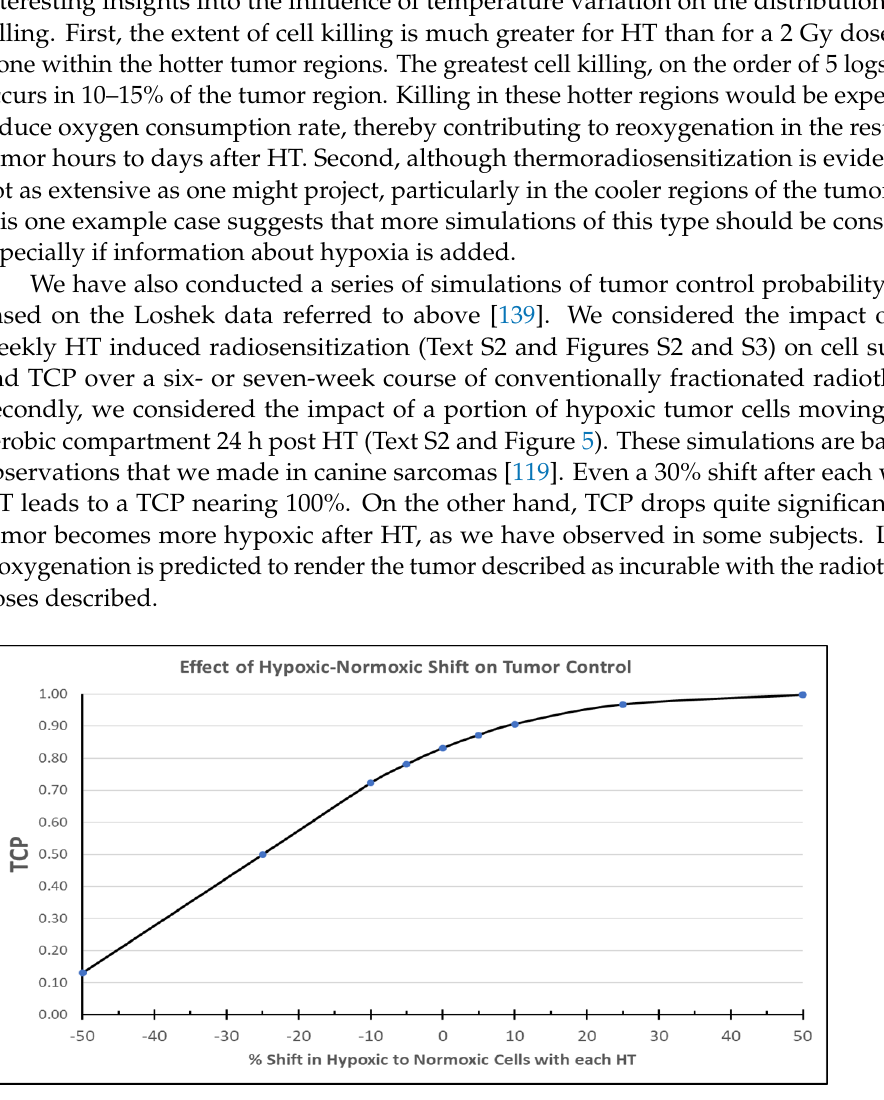
Figure 5. Predicted tumor control probability [TCP] for conventionally fractionated radiotherapy + HT, where HT is administered once weekly. The impact of HT induced reoxygenation at 24 h post HT is depicted, as the proportion of hypoxic cells that reoxygenate vs. proportion of aerobic cells that become more hypoxic after each HT. TCP reaches nearly 100% if even 30% of hypoxic tumor cells reoxygenate 24 h after each HT, thereby affecting cytotoxicity of the radiotherapy fraction given the day after HT. On the other hand, TCP drops quickly in a condition where aerobic tumor cells become more hypoxic 24 h after HT. Although reoxygenation occurs more frequently with HT, one must remain aware of the smaller population of tumors that become more hypoxic after HT, as such effects are predicted to substantially reduce TCP. Details of these simulations are shown in Supplemental Text S2.